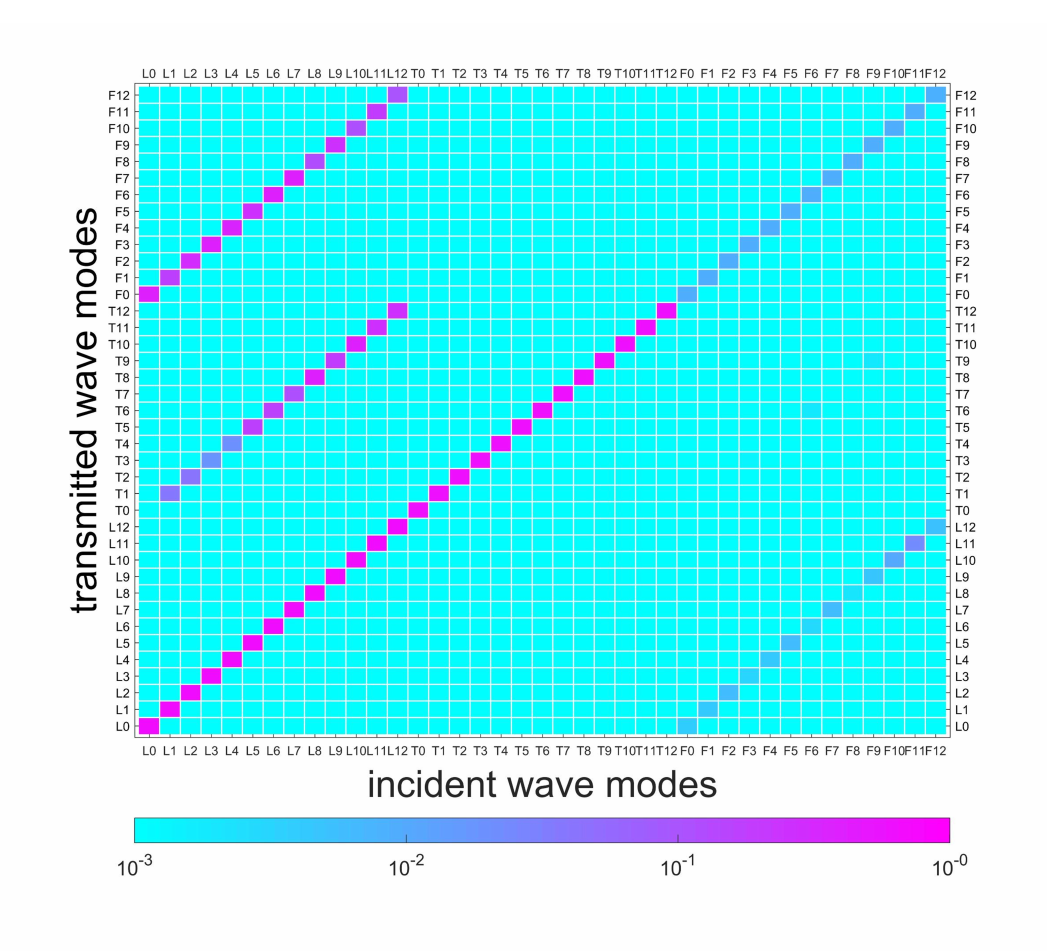
Figure 12. Transmitted waves of the coupling element without damage. The cool color-bar indicates the wave amplitude in the logarithmic coordinate system. The wave amplitudes of conversions higher than 10 − 3 are shown and